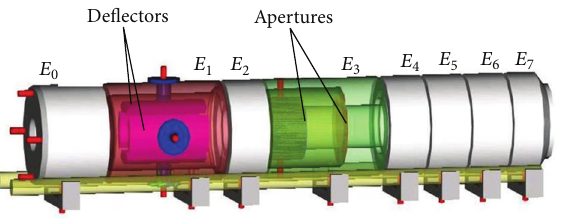
Figure 4: The 3D AutoCAD drawing of the electron gun with seven cylindrical elements, apertures, and deflector